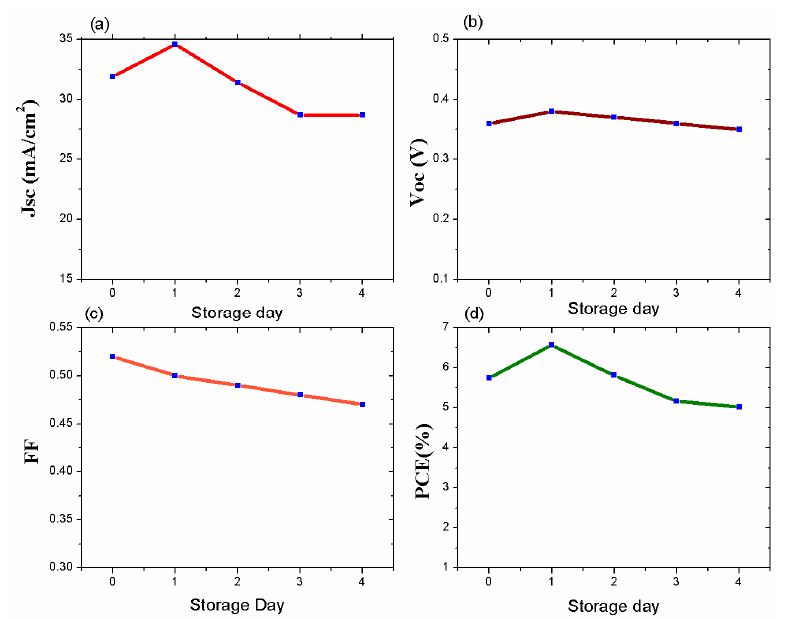
Figure 8. The evolution of the photoactivity parameters with the number of storage days: ( a ) J sc ; ( b ) V oc ; ( c ) FF; ( d ) PCE.